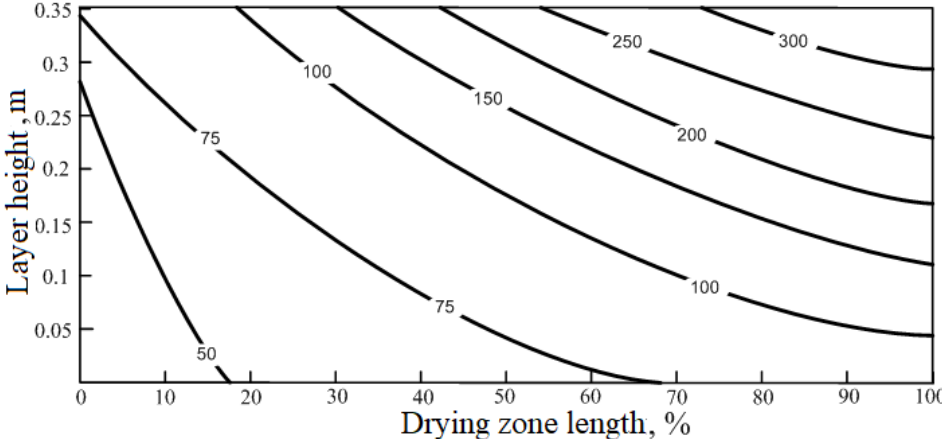
Figure 11. Parametric family of isolines showing the average radial temperature of the pellets, °С.